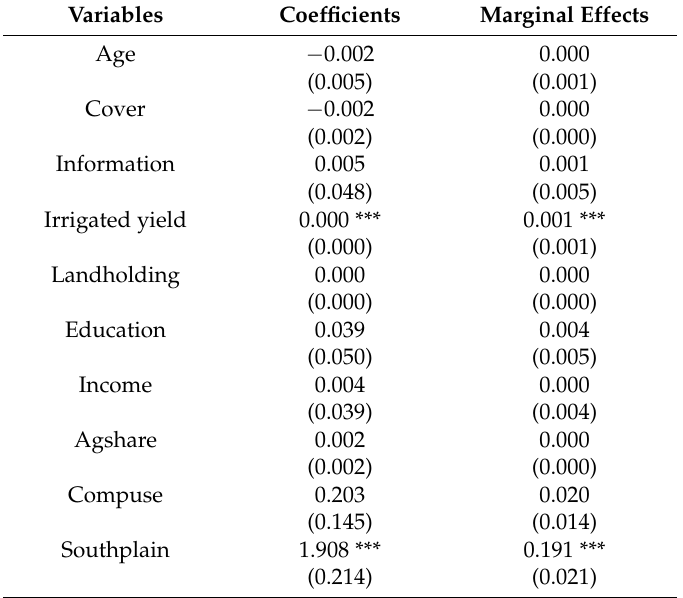
Table 3. Parameter and marginal effects of variables affecting the adoption of water-efficient irrigation technologies